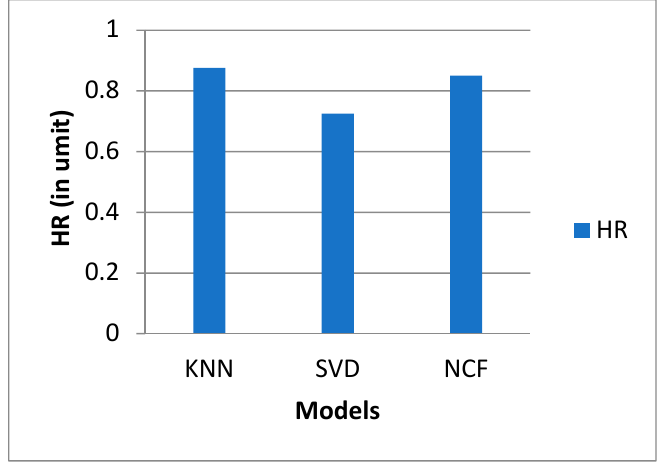
Figure 6. Performance results of different models in terms of HR in 60:40 training–testing scenario.